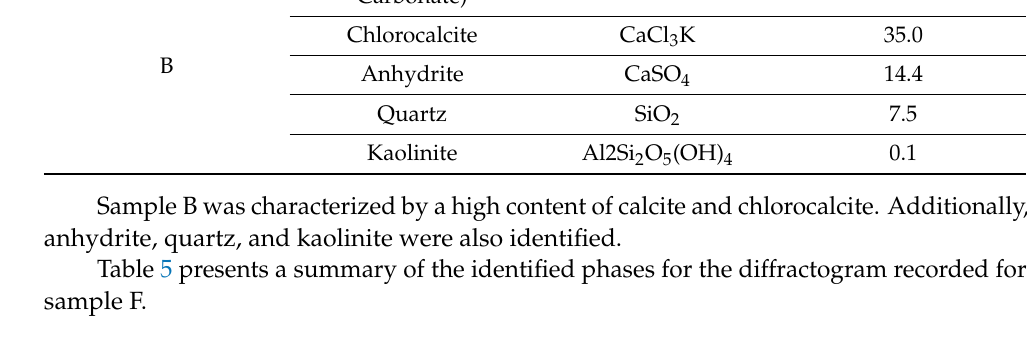
Table 5. Identified phases and their percentage share in conventional fly ash